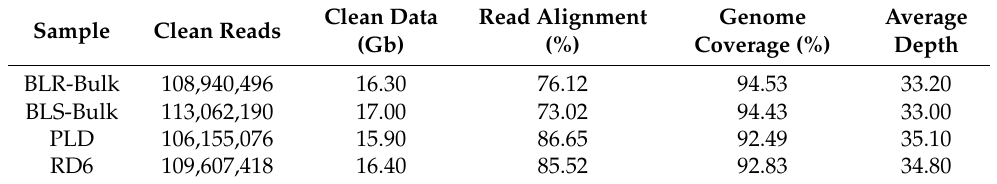
Table 1. Summary of Illumina sequencing data of parental lines and resistant and susceptible bulks.